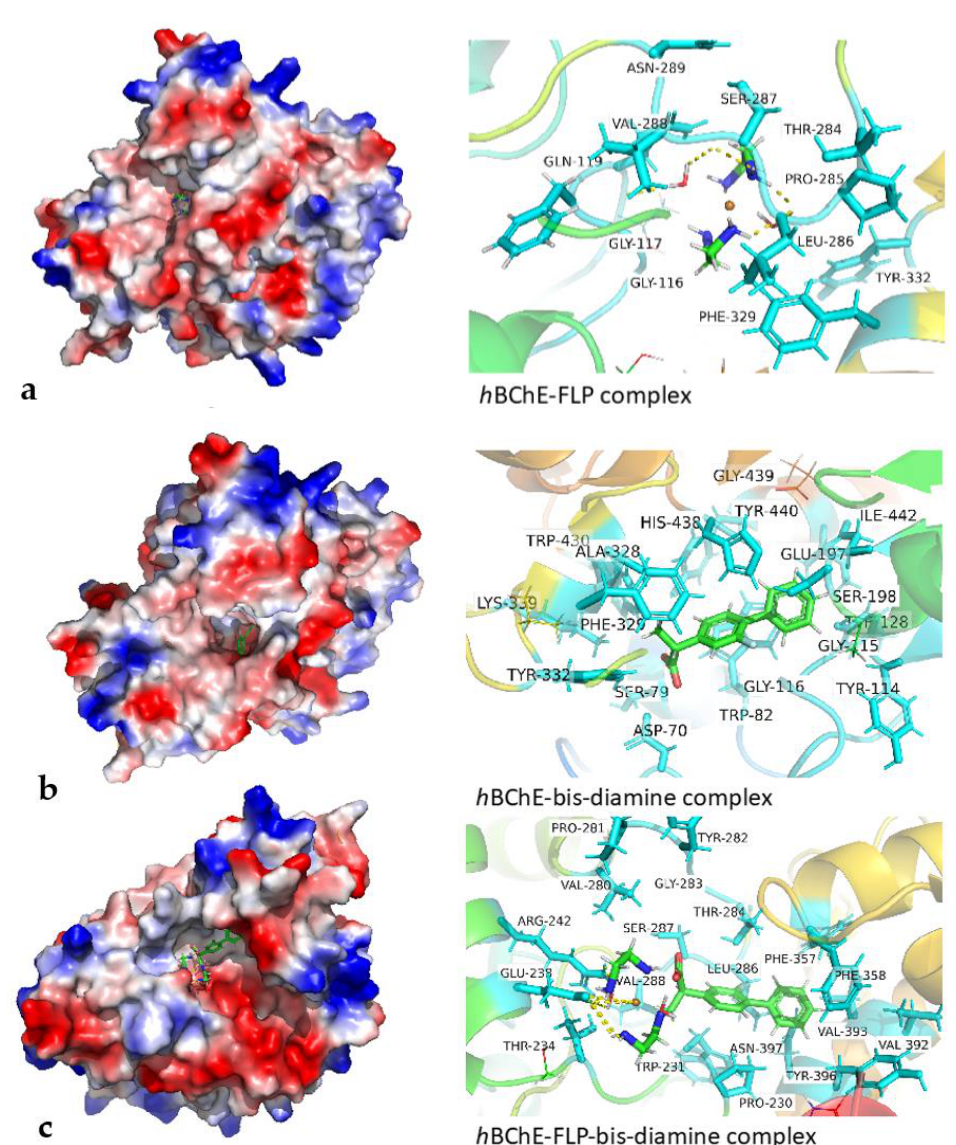
Figure 3. Binding mode of flurbiprofen (FLP) ( a ), bis-diamine metal complex ( b ), FLP-bis-diamine metal complex ( c ) in the catalytic and peripheral pocket of h AChE. The figures on the left show electrostatic potential surface (generated with PyMol) and ligand binding cavities (gorge).